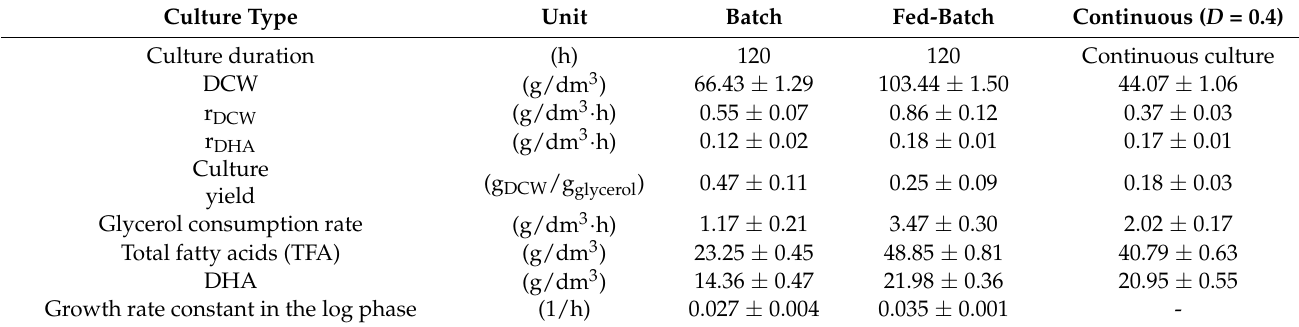
Table 5. Comparison of parameters characterizing the efficiency of Schizochytrium sp. culture and DHA production obtained in the batch, fed-batch, and continuous cultures. Culture Type